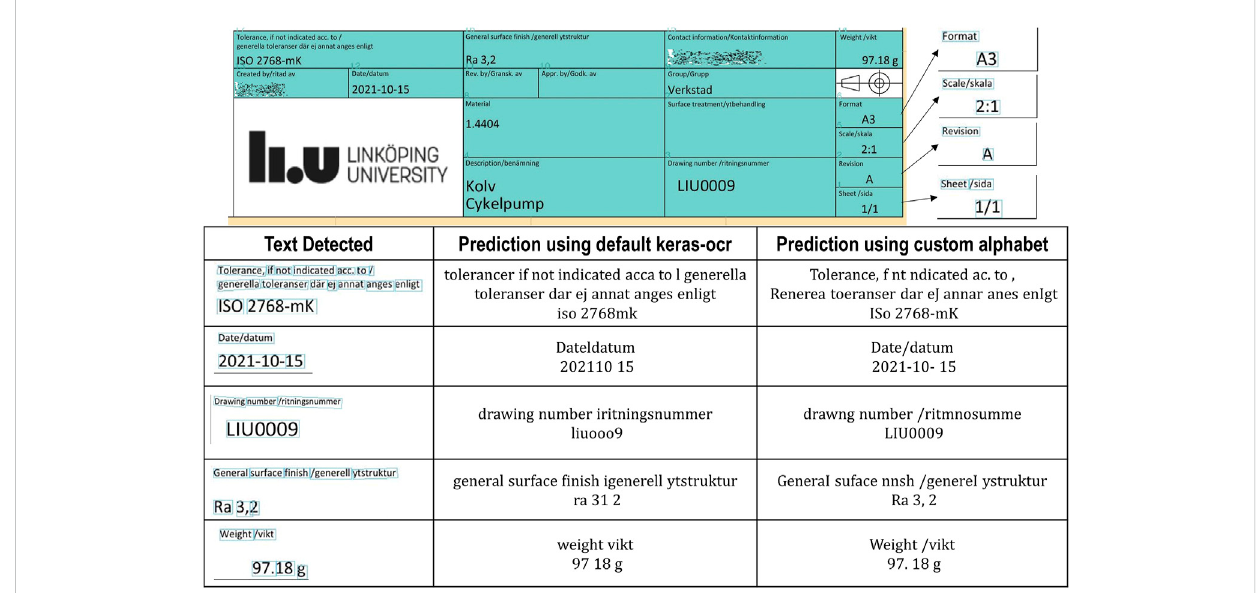
FIGURE 4 Information block pipeline. In the table: boxes extracted from image processing, prediction of the keras-ocr default recognizer and prediction of custom